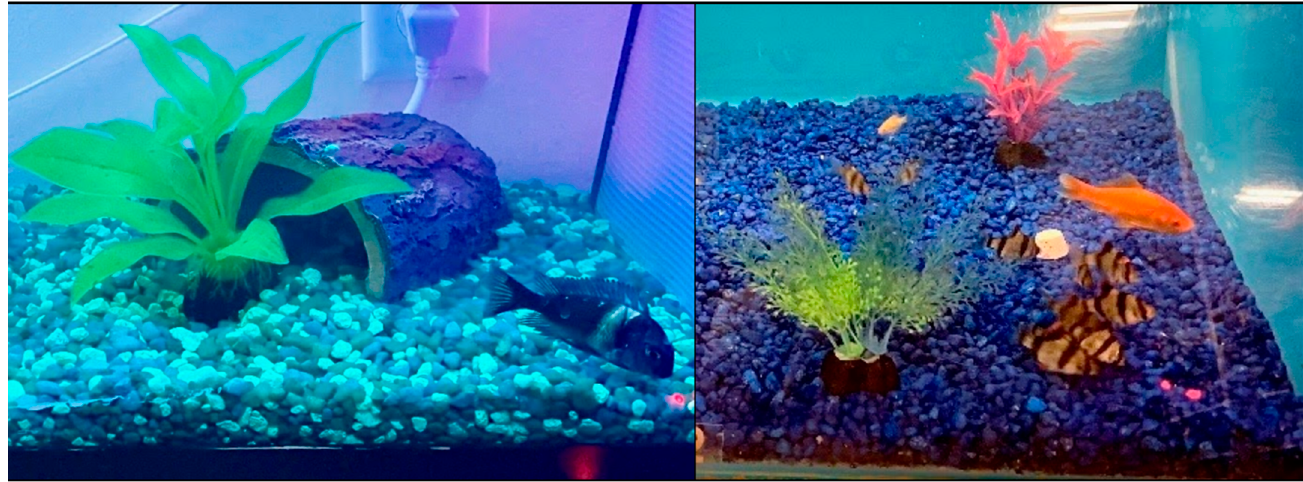
Figure 3. Video stills of a white-spotted cichlid in our home laboratory ( left ) and pet store tiger barbs and goldfish ( right ) orienting towards and chasing after red laser dots. Note that the appearance of two dots in the right hand image is due to reflection of a single laser point on the aquarium glass.